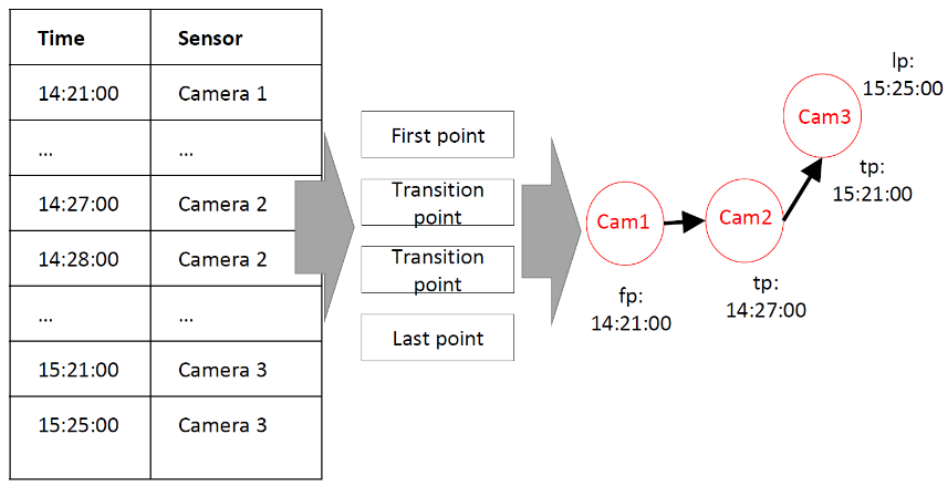
Figure 4. The trajectory data structure of each pedestrian.